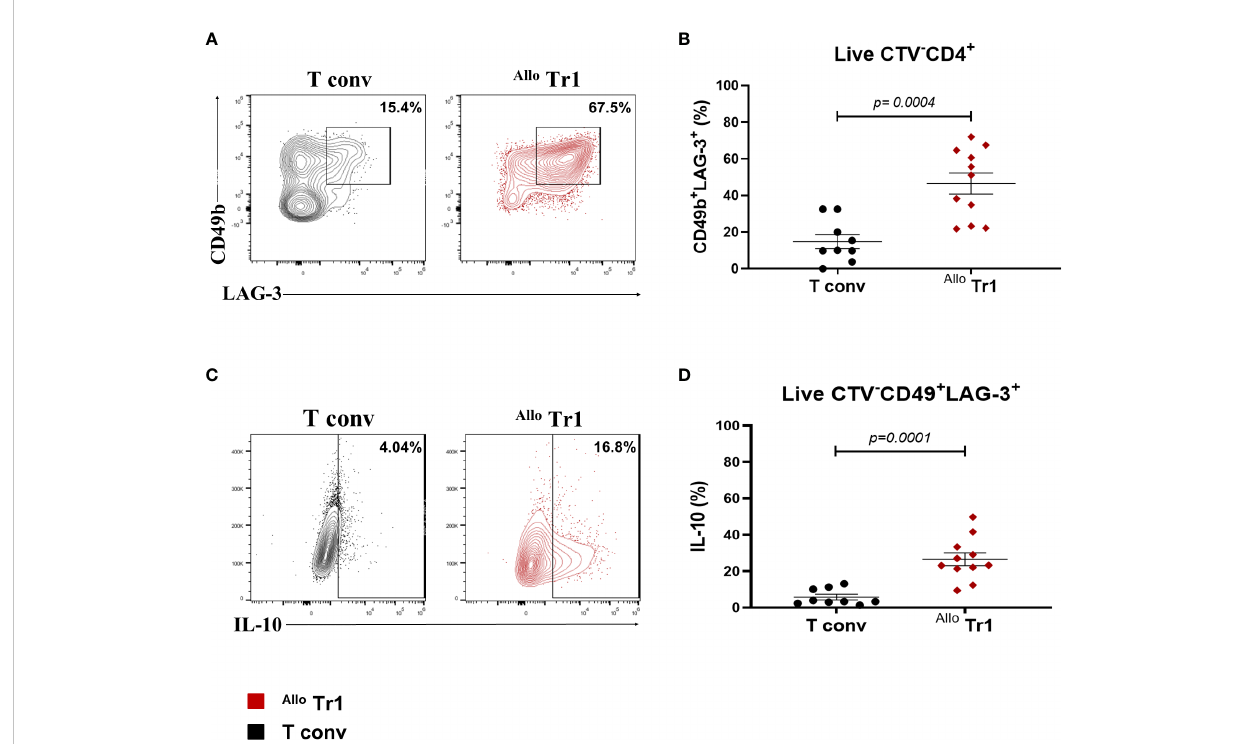
FIGURE 2 DC 10 induces the differentiation of a high percentage of CD49b + LAG-3 + Allo Tr1 cells. nT (CD4 + CD25 - CD45RA + ) cells were co-cultured with allogeneic moDC (Allo T conv) or DC 10 ( Allo Tr1 cells) for 14 days. (A) Representative contour-plot of CD49b and LAG-3 co-expression in proliferating cells from T conv (black) or Allo Tr1 cells (red). (B) Proportion of CD49b + LAG-3 + in Allo Tr1 (red, n= 11) condition culture compared to T conv (black, n= 9) condition. (C) Representative contour-plot of IL-10 production from CD49b + LAG-3 + population in T conv (black) and Allo Tr1 cells (red). (D) CD49b + LAG-3 + Allo Tr1 cells (red, n= 11) showed a signi fi cantly higher IL-10 production compared with CD49b + LAG-3 + T conv (black, n= 9). All experiments were performed in duplicates. Data are representative of six independent experiments. The results are shown as mean ± SEM. The statistical analysis was performed using the unpaired-t test or the Mann – Whitney U